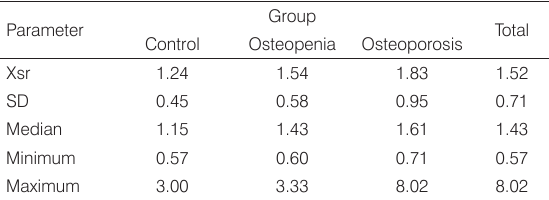
Table 3. Triglyceride level in patients by group (mmol/L).